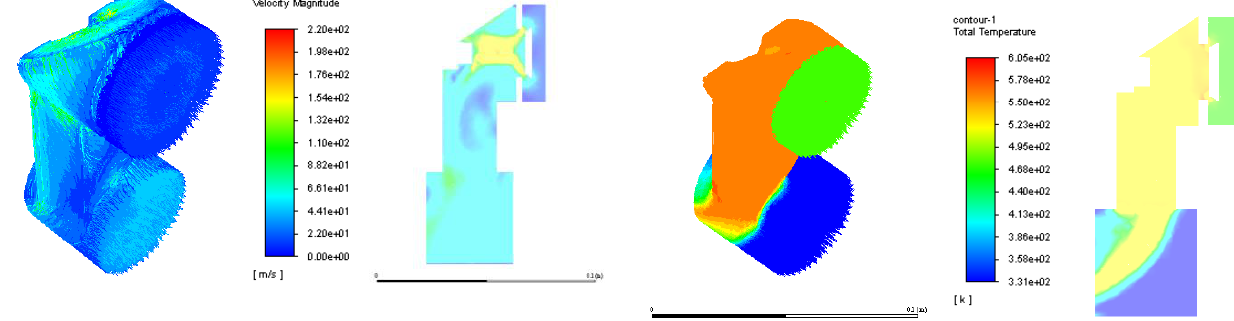
Fig. 11. The flow velocity of the fluid in the new EGR valve